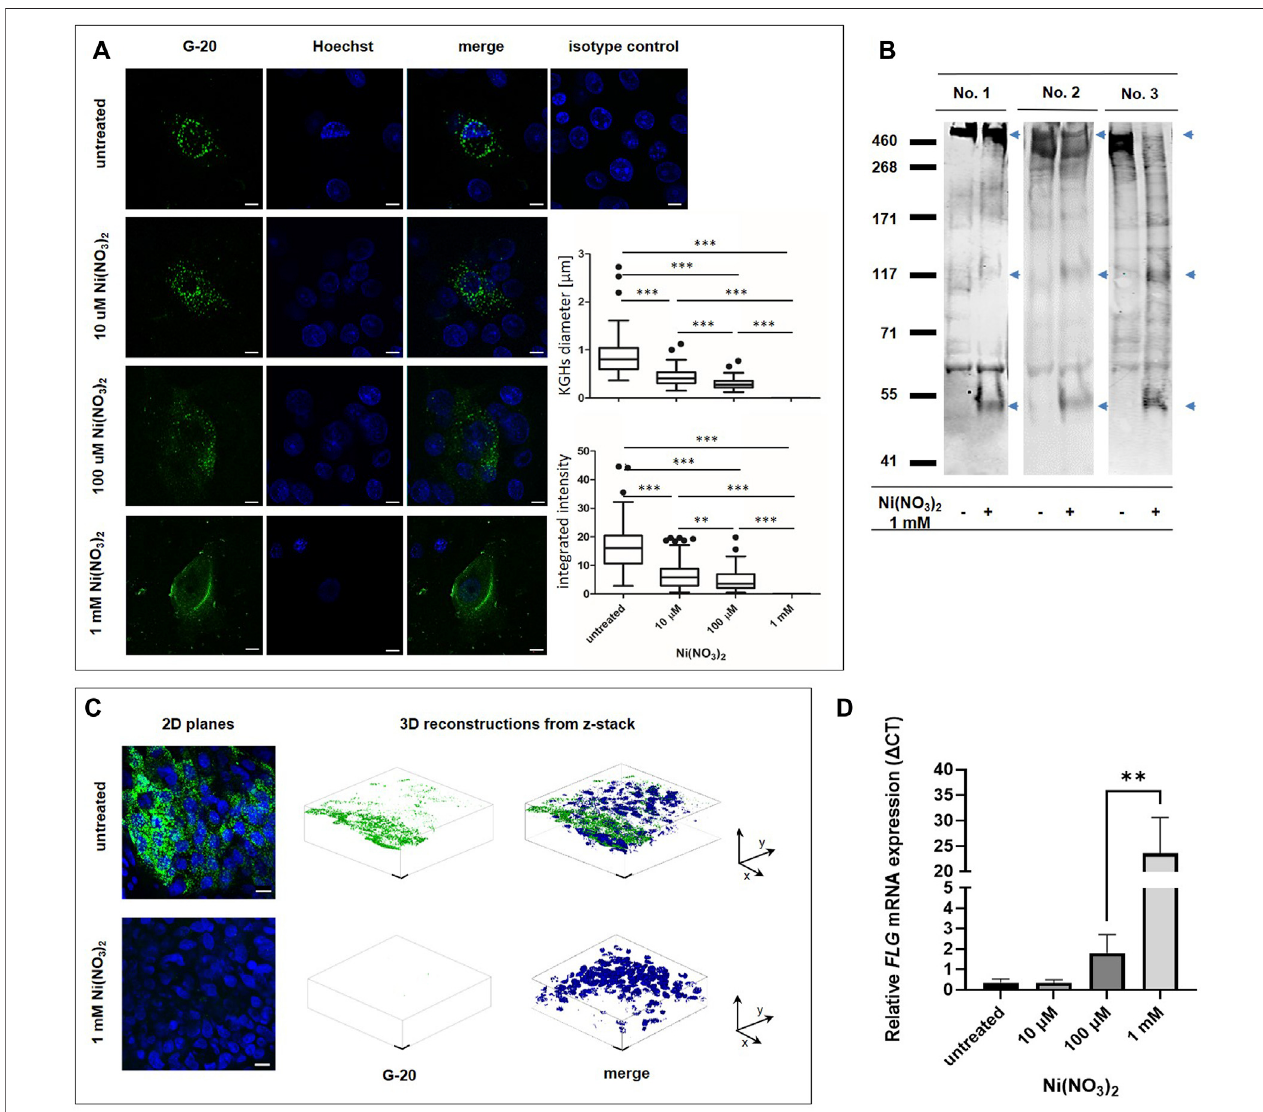
FIGURE 3 | FLG hydrolysis in human keratinocytes in vitro and human epidermis ex vivo . (A) 2D scanning confocal images of fi xed NHEK cells immunostained for FLG (green)) and nucleus (blue) after 24 h of treatment with Ni(NO 3 ) 2 . Scale bar (10 µM). Diameter of KHGs and integrated intensity from the signal are presented on the Tukey box plots (n~100 pooled counts from images from 3 independent experiments). In 1 mM nickel concentration it was not possible to observe granules. Error bars represent standard deviation. p -value = 0.031 ( t -test). The main body of the boxplot indicates the interquartile ranges (IQR). Whiskers represent 1.5 x IQR. The medianismarkedbyhorizontallines.Statisticalsigni fi canceismarkedwithasterisks:(**) p -value=0.0012,(***) p -value < 0.0001(Mann – Whitney U test). (B) Westernblot analysis of FLG level in human epidermal sheets ex vivo after treatment 1 mM Ni(NO 3 ) 2 for 36 h, using internal G-20 anti-FLG antibody. Arrows mark the appearance of additional bands due to the cleavage. (C) Immunostaining of epidermal sheets with anti-FLG antibodies (green and nucleus (blue). 2D planes and 3D reconstructions from z-stack are presented. Scale bar (10 µM). (D) Changes in FLG mRNA expression in NHEK cells upon treatment with Ni(NO 3 ) 2 for 24 h. The graph presents Δ CT values with relative to the TBP1 housekeeping gene expression. Error bars represent standard deviation. p -value = 0.031 ( t -test).